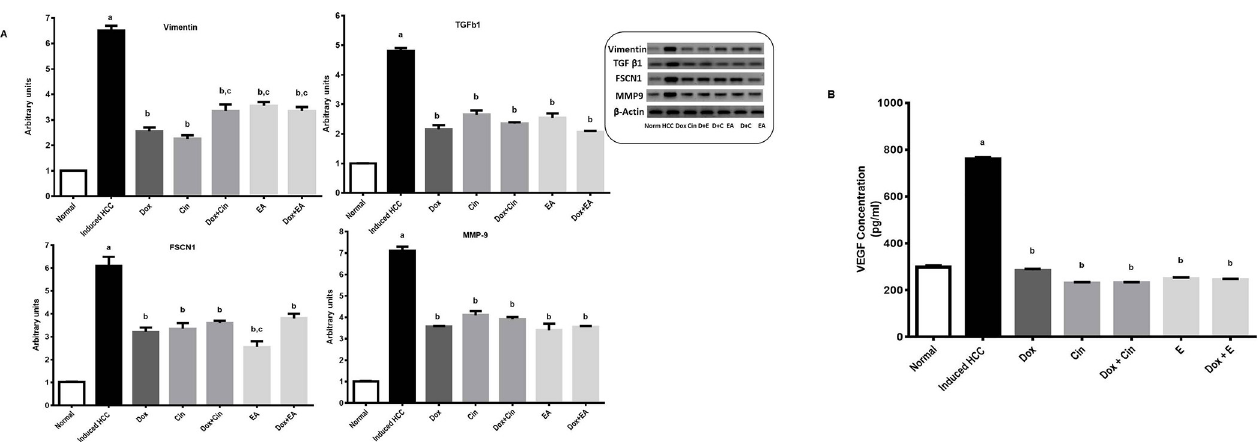
Fig 3. EMT and its regulators in DEN/2-AAF-induced HCC rats. (A) Representative Western Blot of Vimentin, TGF- β 1, FSCN1, and MMP-9 after treatment with 1,8 cineole (Cin), ellagic acid (EA), doxorubicin (DOX), and combinations. Chemiluminescence analysis; optical densities were normalized to β -actin levels and expressed in arbitrary units. The data shown are representative of three independent experiments with comparable results. (B) VEGF concentration in liver homogenate using ELISA kits. Data are presented as mean ± S.E.M, n = 10. ‘ a ’ P < 0.05 vs. normal group, ‘ b ’ P < 0.05 vs. DEN/2-AAF- induced HCC group, and ‘ c ’ P < 0.05 vs. DOX treated group using one-way ANOVA followed by Tukey’s post-hoc test.